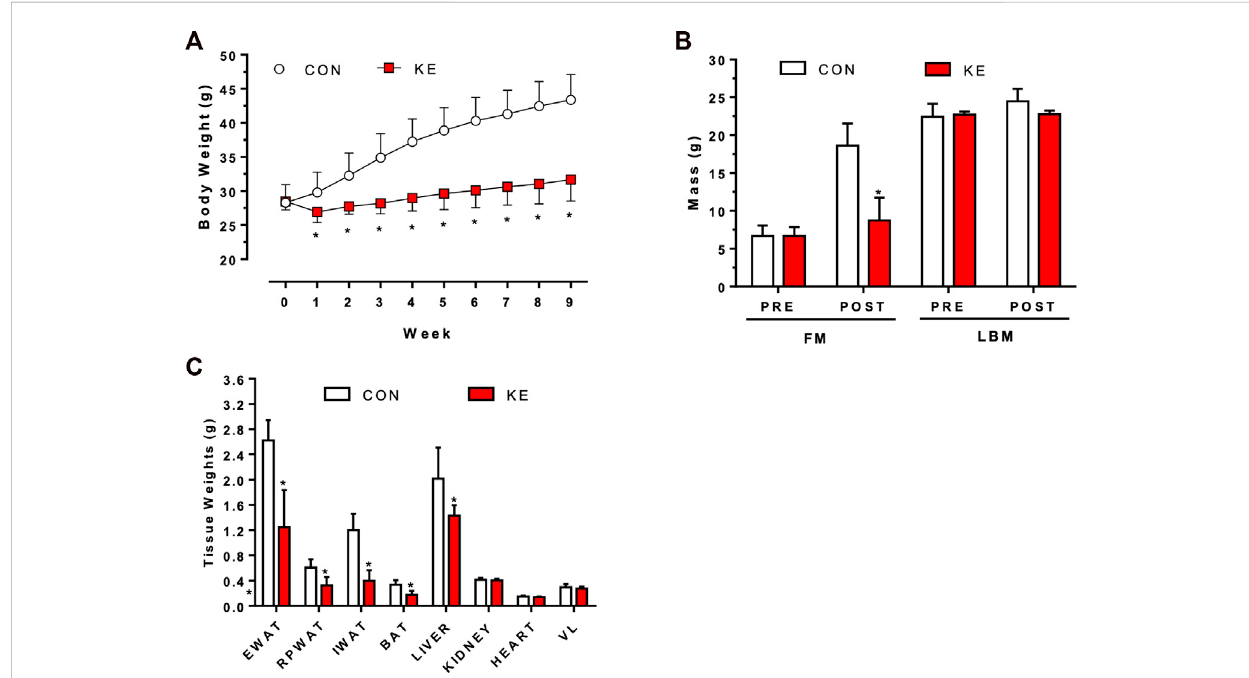
FIGURE 1 Differences in body weight, body composition, and tissue weights after 9 weeks of Control (CON; HFHS) or Ketone Ester (KE; HFHS +25% ketone ester by kcals) diets. (A ) Body weight responses across 9 weeks * p < 0.05, CON vsKE beginning at week 1. (B) Pre- and Post-Fat Mass (FM) and Lean Body Mass (LBM) measurements. * p < 0.001. FM gain in the CON group was signi fi cantly greater than the KE group. * p < 0.001. (C) Final tissue weights for epididymal (EWAT), retroperitoneal (RPWAT), and inguinal (IWAT) white adipose tissue, brown adipose tissue (BAT), liver, kidney, heart, and vastus lateralis (VL). * p < 0.05 for all adipose tissue weights and liver weight. Values are presented as means ± SD.